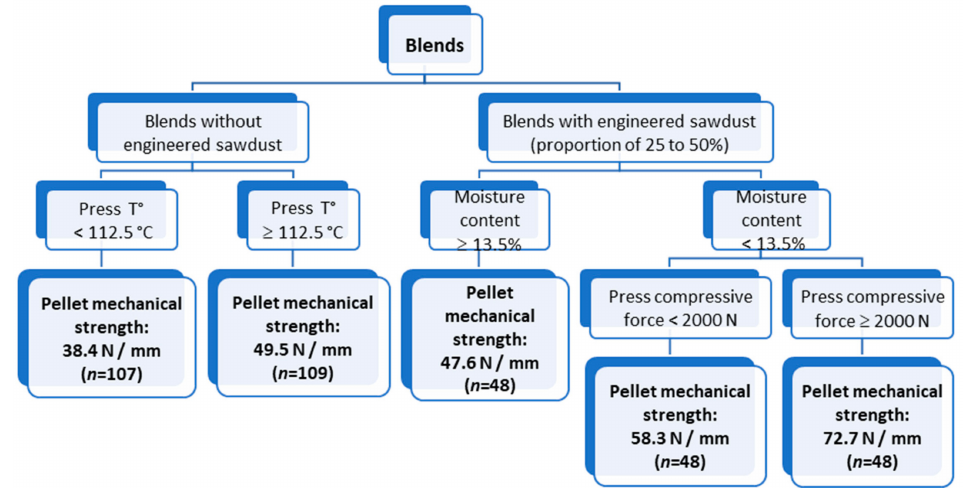
Figure 6. Regression tree of pellet mechanical strength ( n = 360), with averages and number of observations (in